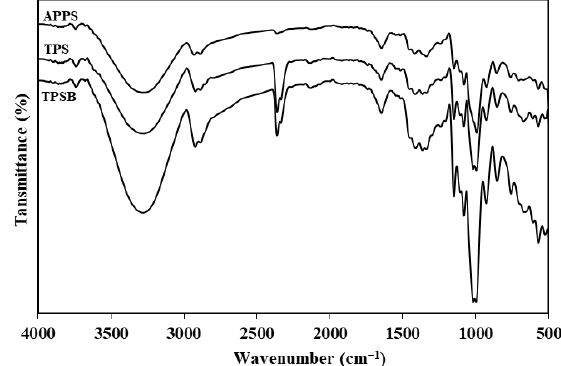
Figure 1. FTIR spectrum of APPS, TPS and TPSB.